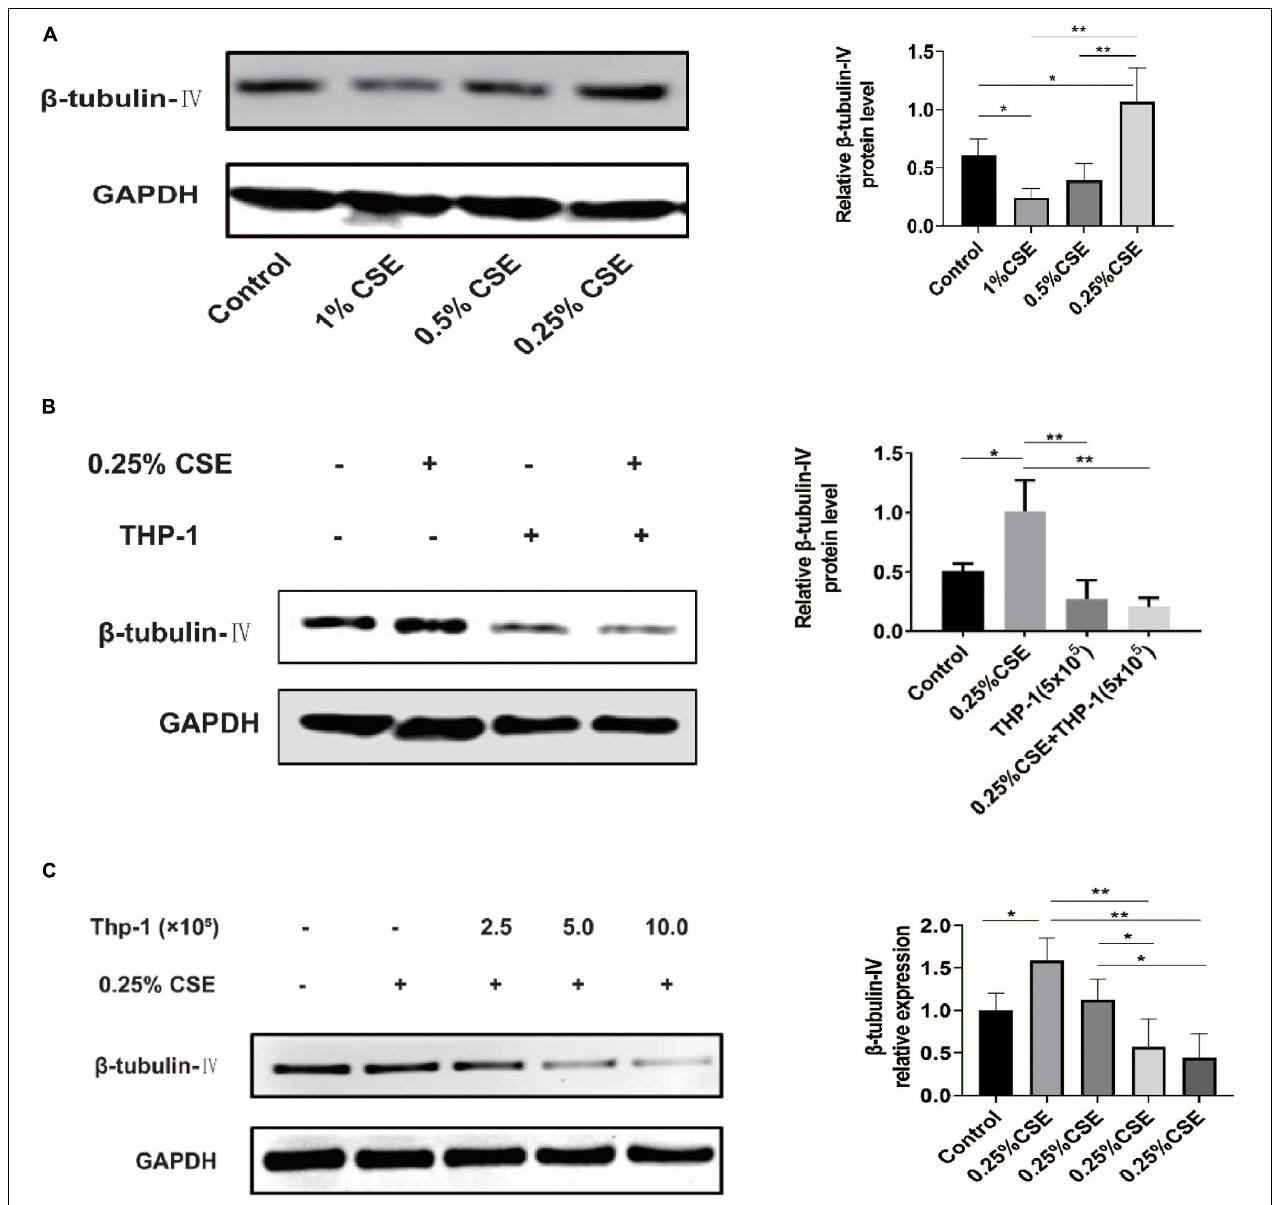
FIGURE 4 | β -tubulin-IV protein levels of BEAS-2B cells after the stimulation of cigarette smoke extract (CSE) and/or THP-1 cells. (A) β -tubulin-IV protein levels of BEAS-2B cells after the stimulation of different concentrations of CSE. (B) β -tubulin-IV protein levels of BEAS-2B cells when co-cultured with THP-1 cells under the stimulation of 0.25% CSE. (C) β -tubulin-IV protein levels of BEAS-2B cells when co-cultured with different numbers of THP-1 cells under the stimulation of 0.25% CSE. All β -tubulin-IV protein levels were quantitated by densitometry and normalized to GAPDH (* P < 0.05, ** P < 0.01).